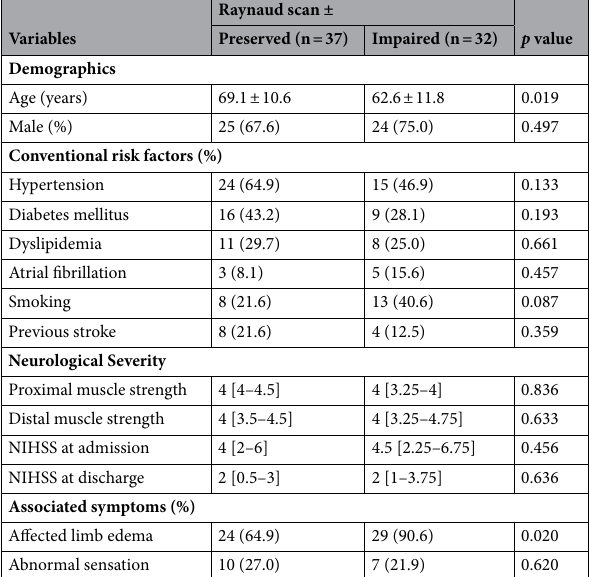
Table 1. Baseline characteristics of study population. NIHSS National Institutes of Health Stroke